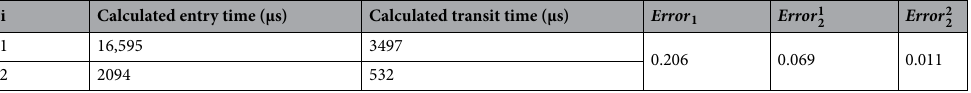
Table 8. Errors and calculated entry and transit times for the best values of the model parameters for the lung cancer cell at the two flow rates of Table